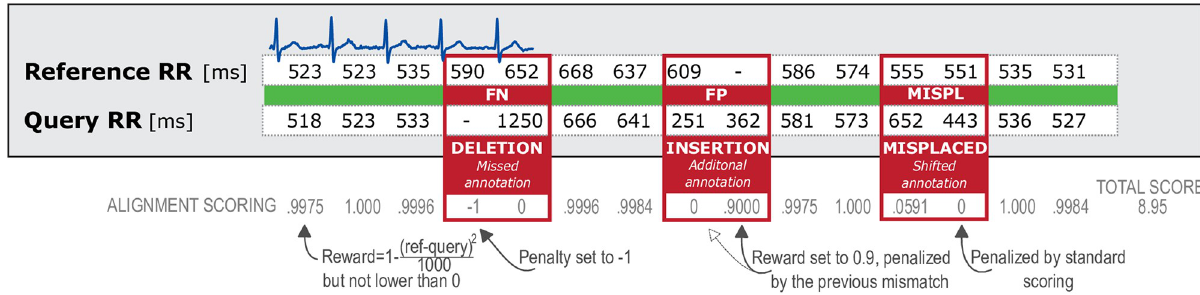
Fig 4. Illustration of a Smith-Waterman-like algorithm for RR interval sequences to identify incorrect RR intervals in a query sequence.